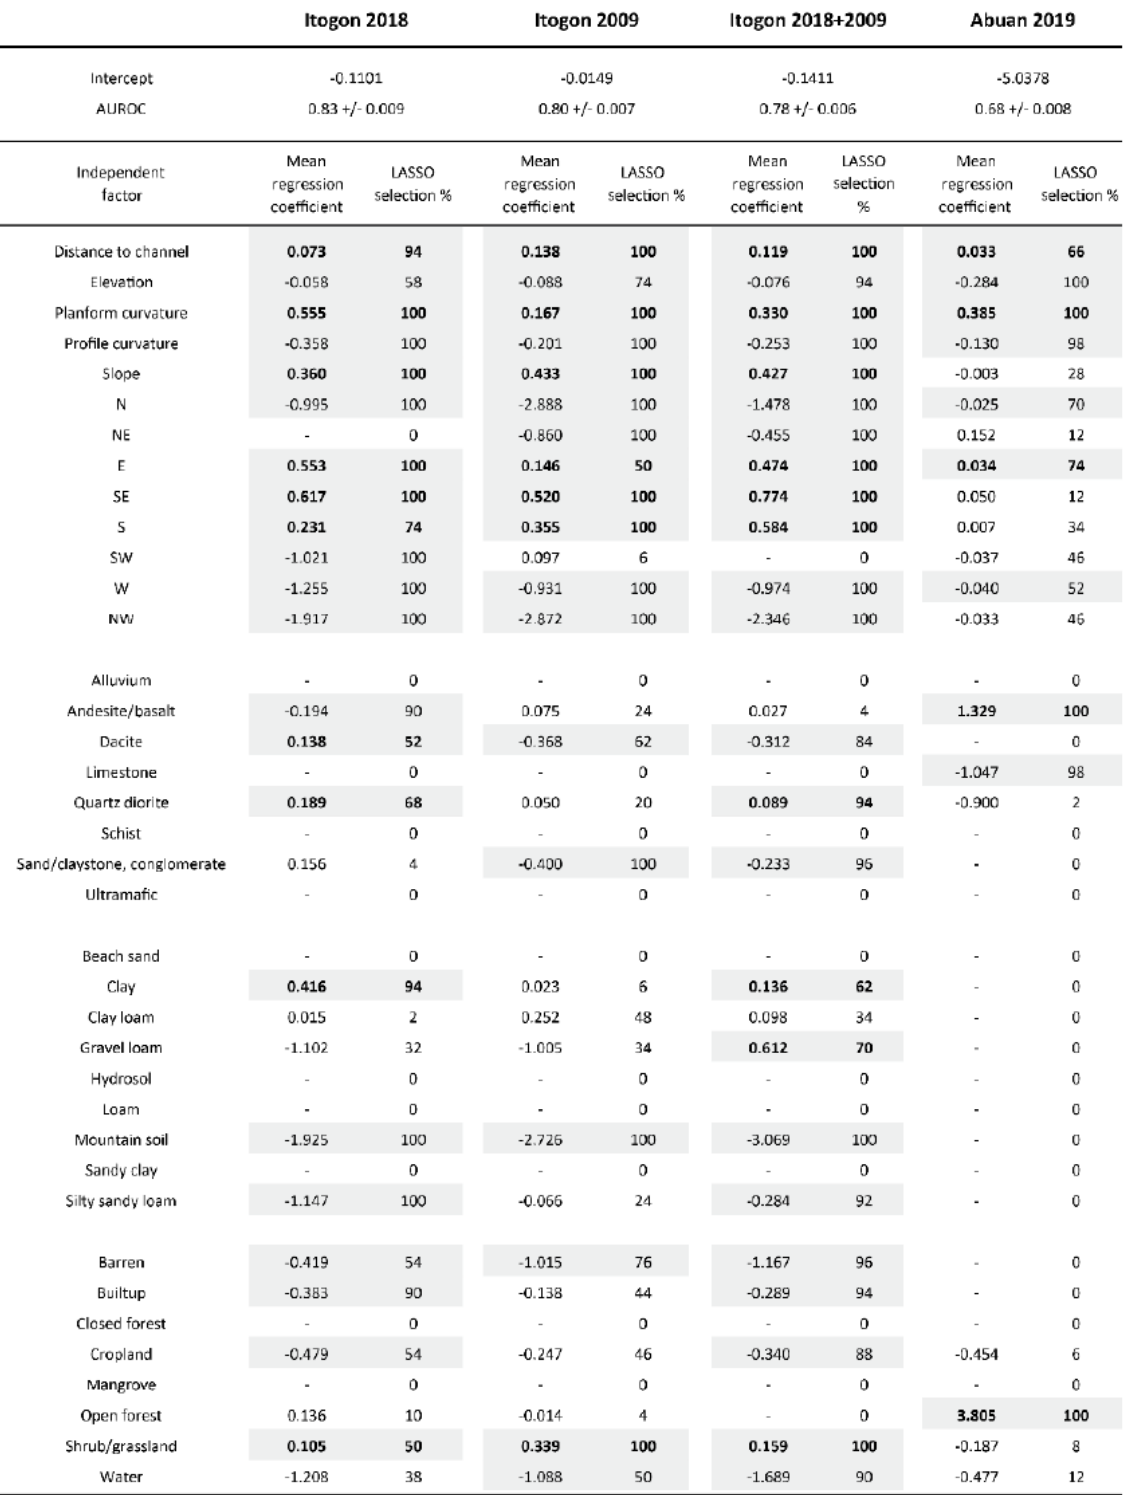
Table 1. Summary of the BLR LASSO results obtained for each of the four developed models. All numbers are the mean of the 50 runs undertaken for each model. The AUROC value is the accuracy of the model at classifying the landslide data used to train the model. Grey highlighted cells are all those with > 50% selection by the LASSO. Bold cells are those with a positive influence on landslide